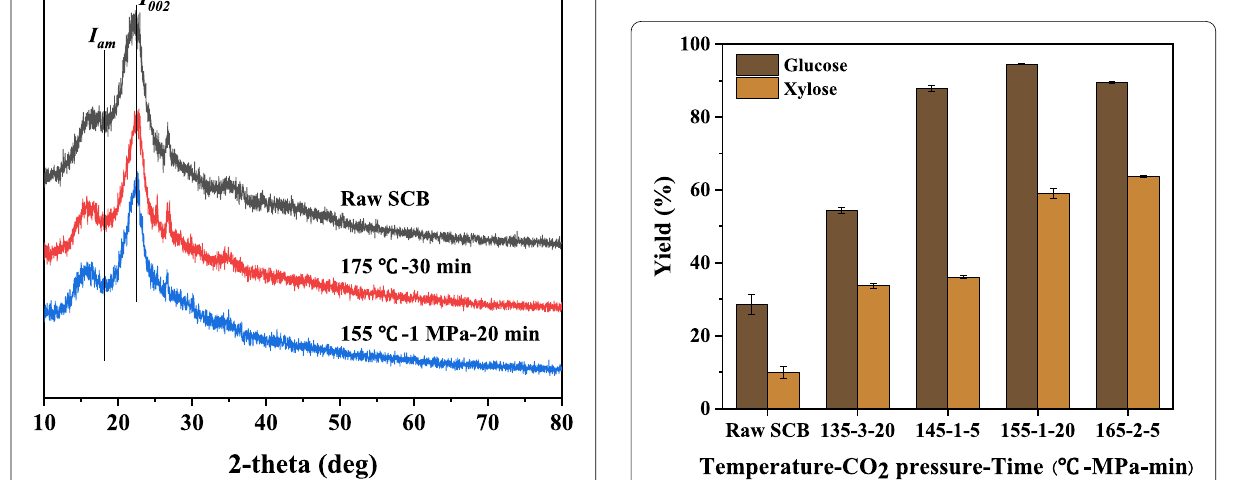
Fig. 5 The yield of fermentable sugar produced by enzymatic hydrolysis